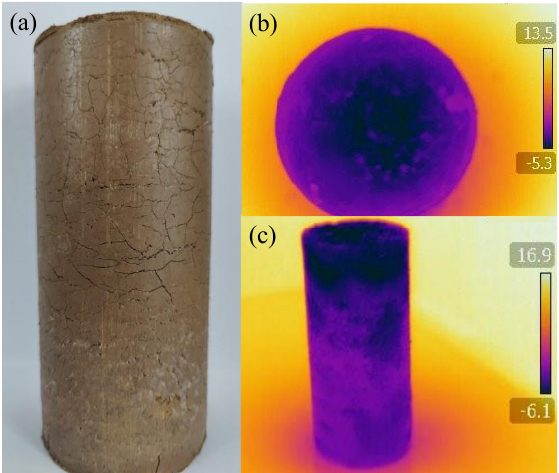
Figure 4. Optical and thermographic photographs. ( a ) Optical photograph. ( b ) Thermographic photograph of the top surface. ( c ) Thermal imaging photo of the front side.